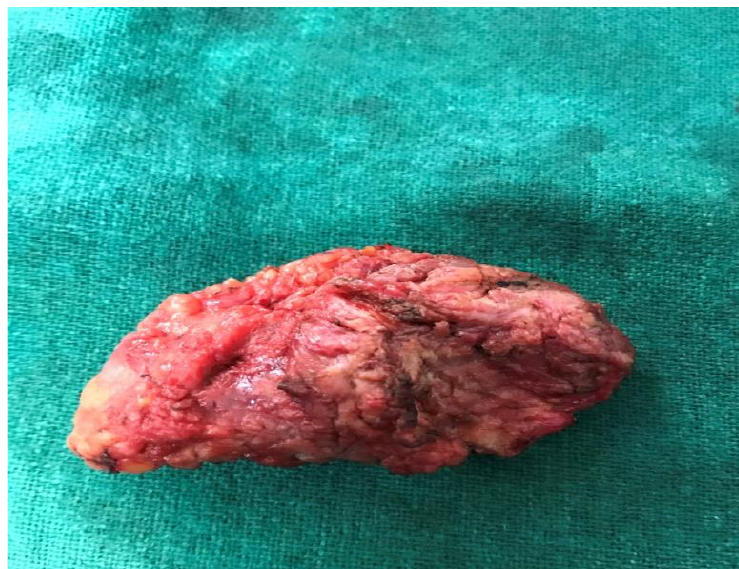
Figure 2. Wide local excision 6 × 4 × 1.4 cm; grayish-brown to black in color.